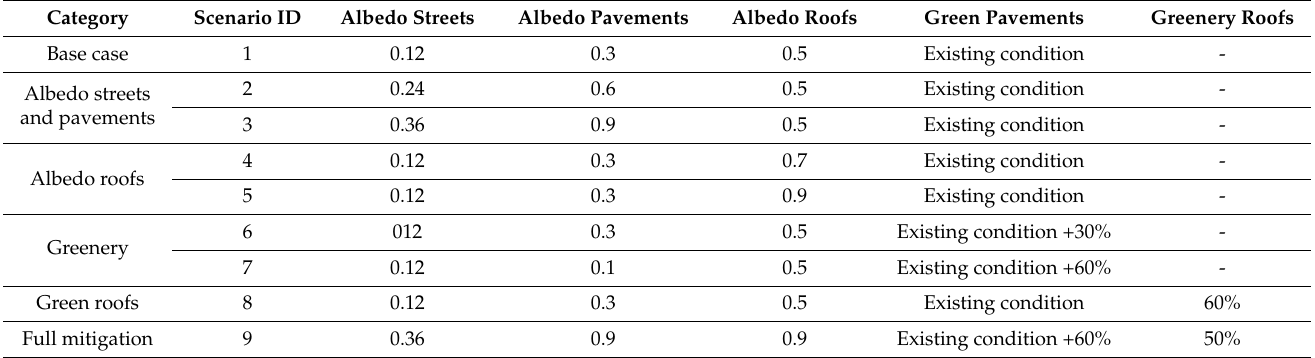
Table 1. Mitigation scenarios applied to the three parts.